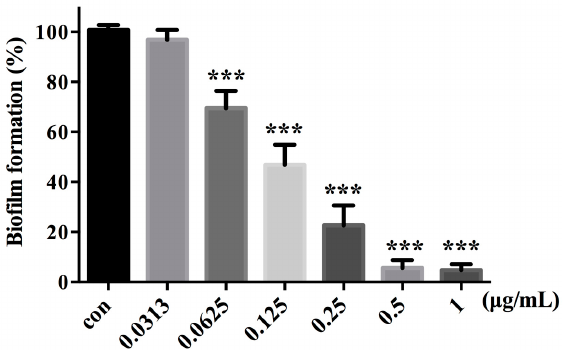
Figure 5. 16g inhibits C. albicans biofilm formation in vitro. Biofilm formation was evaluated by XTT reduction assay using C. albicans SC5314. The results were repeated for two times. *** p < 0.001, ( t test).